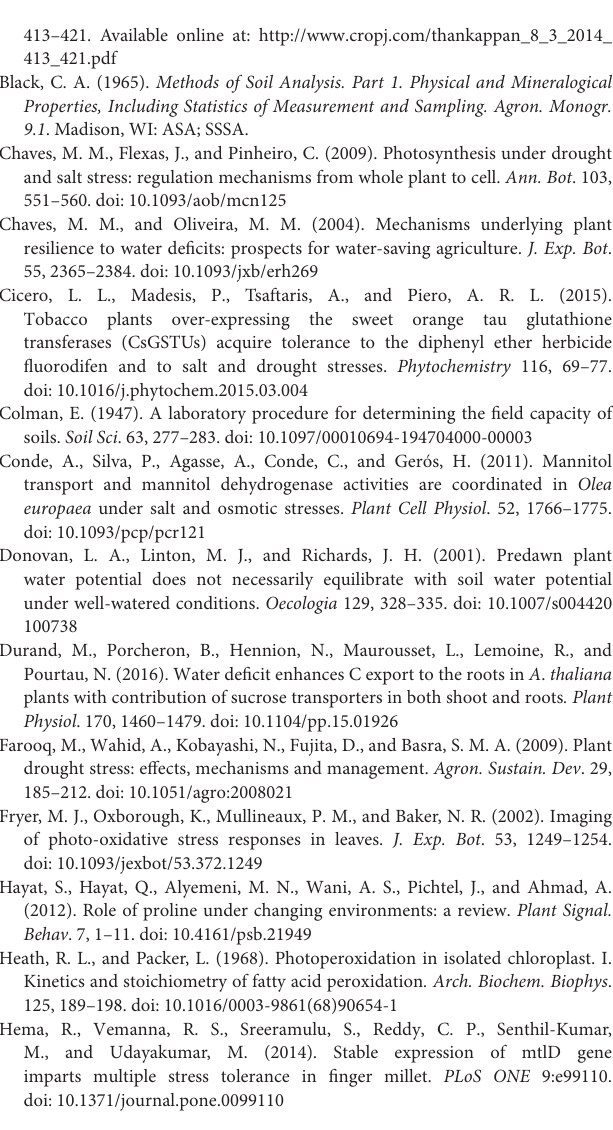
Figure S1 | PCR based reconfirmation of transgenic lines using mtlD transgene specific primers in T5 generation. Where, lanes 1–4 are transgenic lines MTD 1, MTD 2, MTD 3, and MTD 4, respectively; P, Positive control ( mtlD gene-construct); N, Negative control (WT: GG − 20). The primer used was MtlD 694 Fwd- 5 ′ TCA ATC AGG TGG TAC TTG ATG C3 ′ and MtlD 694 Rev − 5 ′ TAG CGC TTG ATC AAT ACT GCA C3 ′ which gave 694 bp amplification only in the positive control and T lines. Figure S2 | Estimation of photosynthetic parameters of wild-type and transgenic lines under well-watered conditions. Where (A) Comparative photosynthetic rate, (B) Stomatal conductance, (C) Transpiration rate, and (D) SPAD values of WT and transgenic lines at 0, 10, and 24 days. The mean values ± SE ( n = 3) followed by similar lower case letters within a column are not significantly different ( P ≤